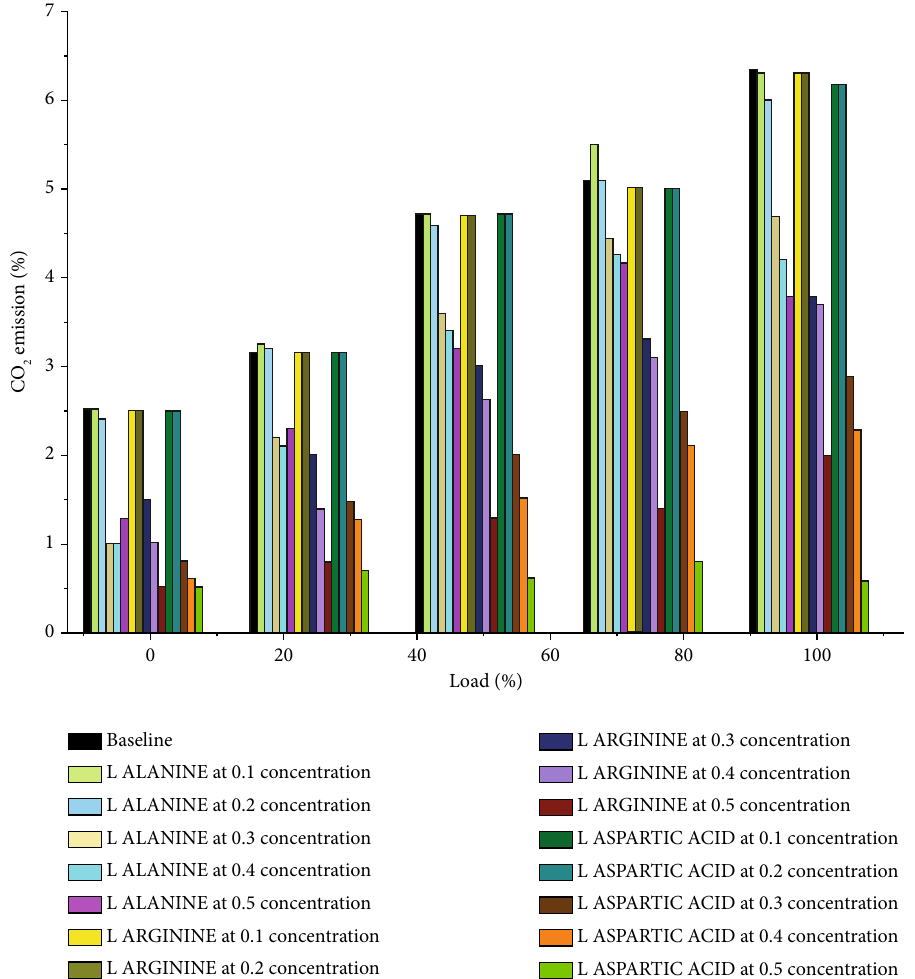
Figure 9: The di ff erence in carbon dioxide with respect to engine